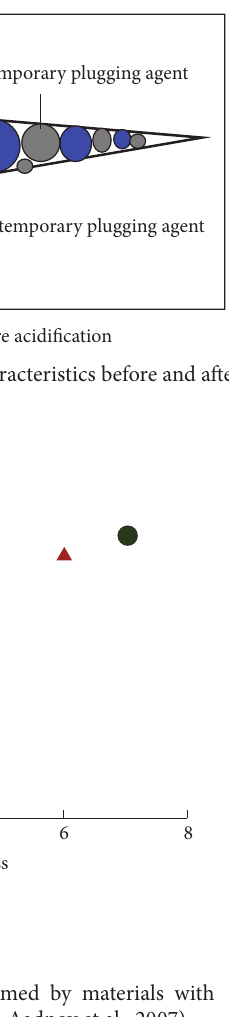
Therefore, the filter cake consisted of quartz, the crushing pressure was maximum, and the hardness was